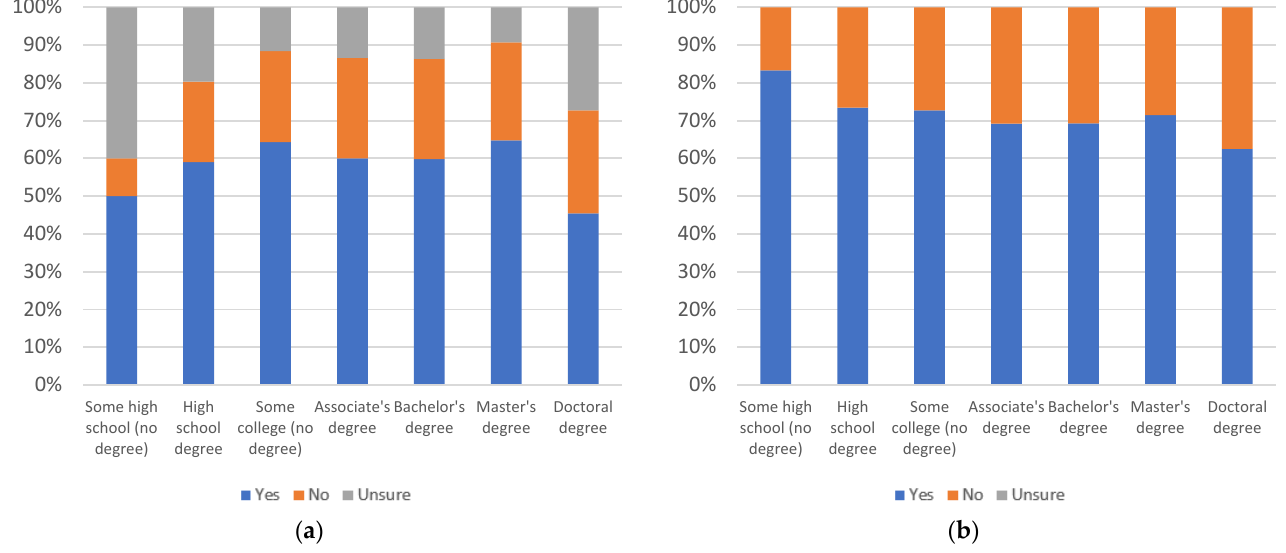
Figure 66. Label trustworthiness judging use, by education level: ( a ) with uncertain respondents (left) and ( b ) without uncertain respondents (right).